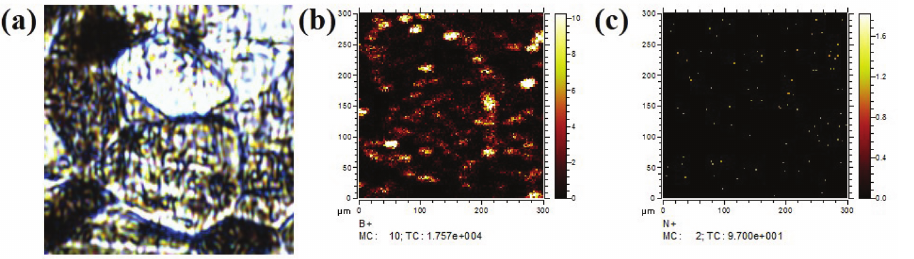
Figure 8: The distribution of the elements in the deformation area of alloy B1 at 1000°C investigated by the SIMS: (a) the microstructure of the deformation area, (b) the distribution of the B atoms and (c) the distribution of the N atoms.